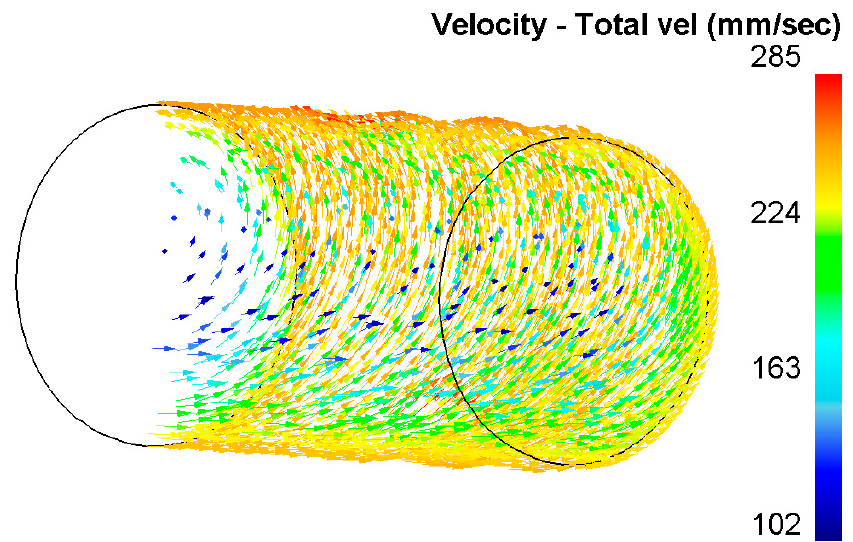
Figure 4. Vortex metal flows in deformation zone after 37-30 mm of radial shear rolling at RSP-14/40 mill.